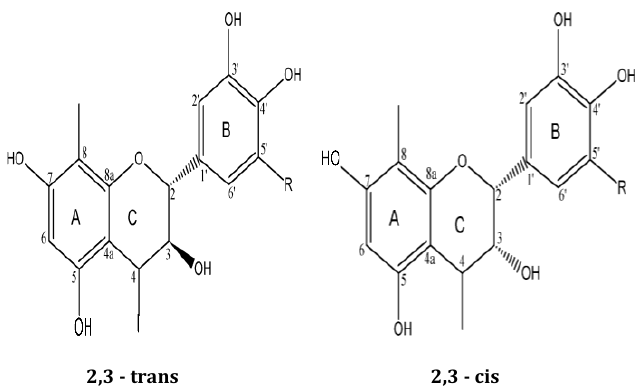
Figure 2. The structure of trans (left) and cis (right) subunits of condensed tannins; including, R indicates either H = procyanidins (PC) or OH = prodelphinidins (PD) as described by as described by